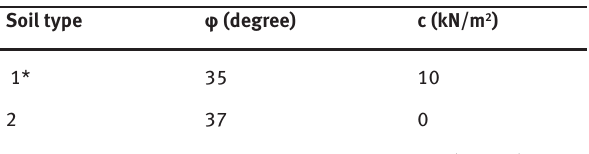
Table 5: Analysis series for a single and group of piles with different depth ratio